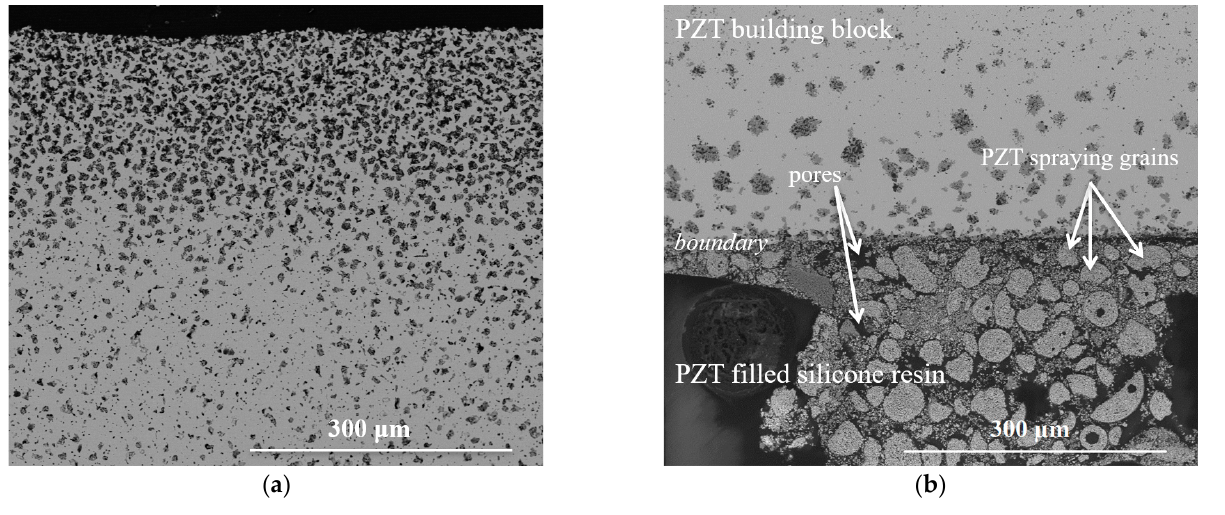
Figure 2. Mechanical connectivity of the interface between PZT building blocks and PZT-filled silicone resin. The line indicates the interface between the PZT blocks and filled resin. ( a ) Surface of a sintered PZT building block. ( b ) Interface between PZT building blocks and PZT-filled silicone